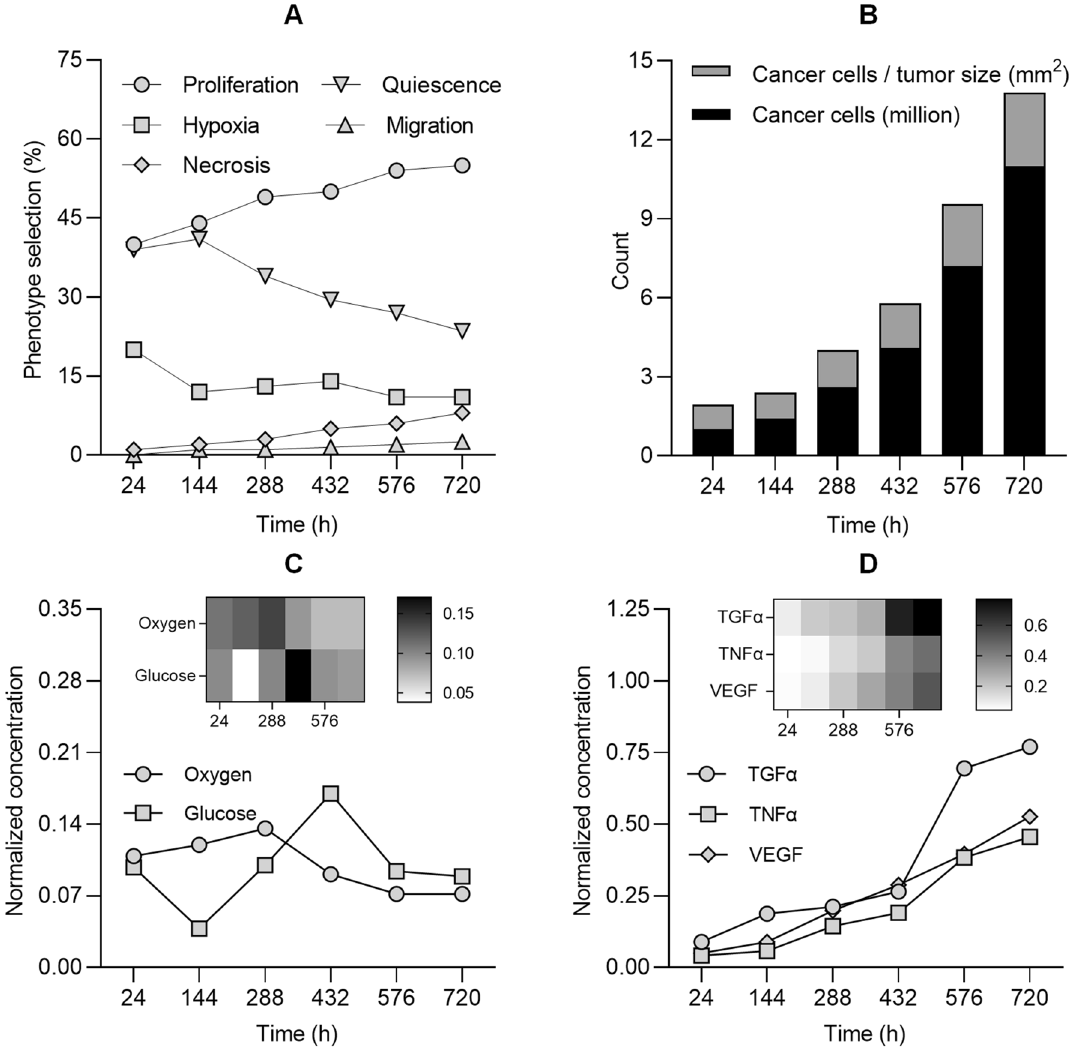
Figure 2. ( A ) Dynamic behavior and cancer cell phenotype selection during the test phase of the multiscale computational model. ( B ) Cumulative number of new cancer cells relative to tumor size during the test phase. Additional nutrients are supplied by the new microvascular network that further promotes tumor growth. Changing ( C ) oxygen and glucose concentrations and ( D ) transforming growth factor alpha (TGFα), tumor necrosis factor alpha (TNFα), and VEGF concentrations within the tumor microenvironment Cells and vessels can be regarded as discrete entities (also referred to as agents) that can predict their pheno- types (i.e., actions) autonomously. This implies they act on their own without explicit direction in response to situations they encounter. The dynamic behavior of a tumor and the TME governing cancer growth during the test phase are detailed in Fig. 2A. In the training phase, as the TME changes at different scales following model rules, agents will respond to these changes by altering their action accordingly. This behavioral data is generated, stored, and then used for prediction during the test phase. One distinction between cancer and normal cells is that the later display density-dependent inhibition of proliferation 22 . As shown in Fig. 2B, model behavior dictates that CCs continue to proliferate independent of cell density. Furthermore , tumor size and the corresponding number of CCs on different days provides information about the tumor growth behavior. Once CCs stimulate microvessel growth by VEGF signaling, new microvessels nourish the growing cancer leading to increased cancer size. Following, microvascular sprouts were created after accumulation of CCs, which were recruited from the parent vessels. This programmed sequence of events, which controls sprouting in microvascular branch devel- opment, results in the tumor being increasingly penetrated by capillary vessels. Model behavior dictated that both oxygen and glucose concentrations remained relatively stable throughout the simulation period, Fig. 2C. Microvascular networks with shorter than average vessel lengths produced larger cancers and led to reduced nutrient concentration around the tumor periphery. As the difference between expansion of the microvascular network and cell population increased, nutrient concentration increased too and CCs were instructed to favor proliferation and migration with a greater probability compared to other phenotypes (see Fig. 2A). Furthermore, when transforming growth factor (TGFα) or tumor necrosis factor (TNFα) reaches neighboring cells, they are